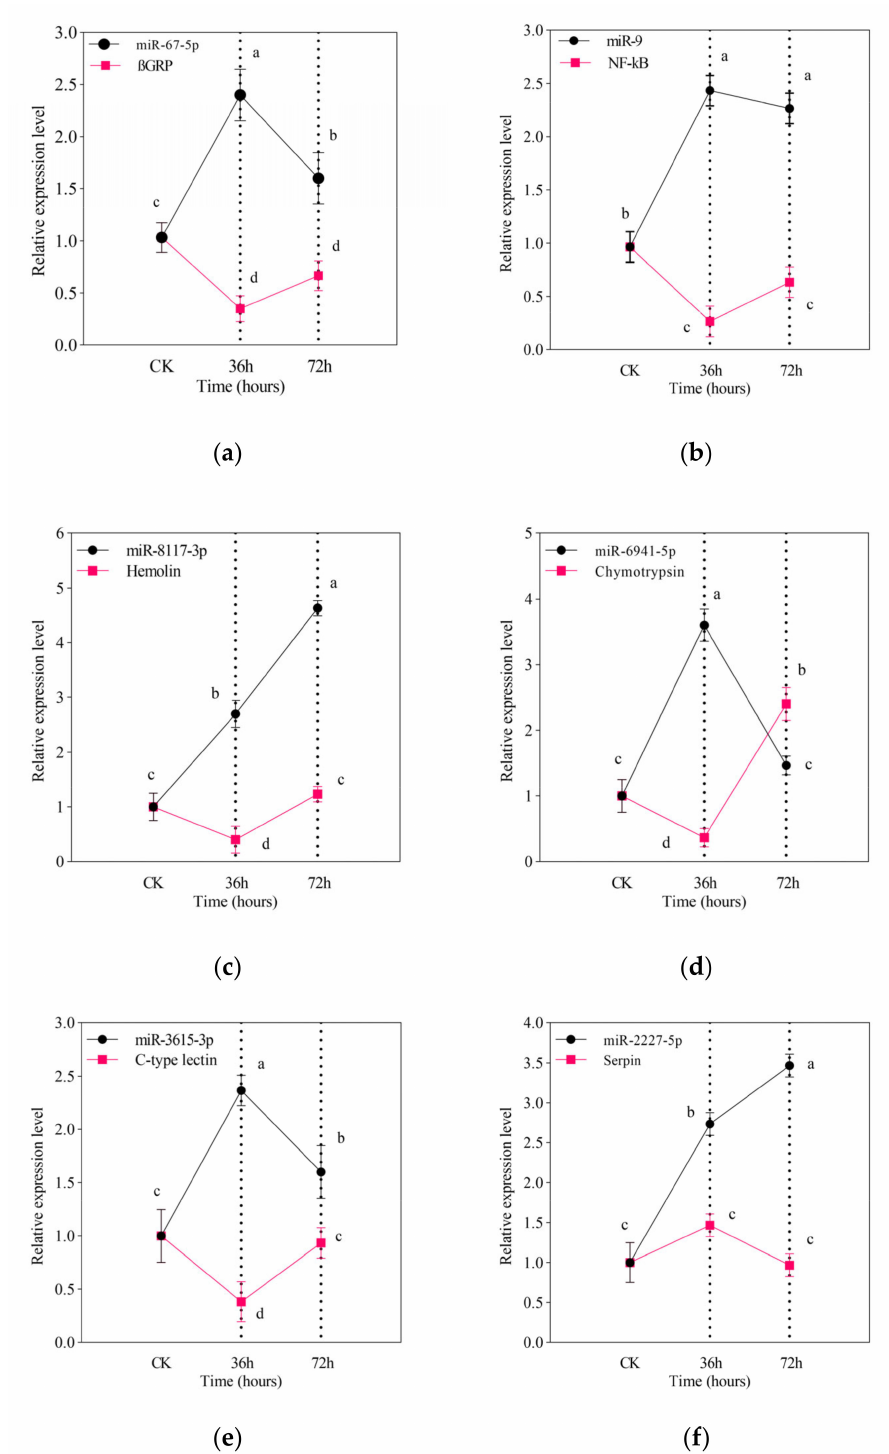
Figure 2. RT-qPCR validation of known miRNAs and their targets mRNAs. ( a ) miR-67-5p target β GRP; ( b ) miR-9 target NF- κ B; ( c ) miR-8117-3p target Hemolin; ( d ) miR-6941-5p target Chymotrypsin; ( e ) miR-3615-5p target C-type lectin; ( f ) miR-2227-3p target Serpin followed by M. anisopliae infection at different course (36 and 72 h). Relative fold change of mRNA and miRNAs were normalized using RPS13 and U6, respectively, as an internal control. Error bars show 95% confidence intervals (CI). Letters indicate significant differences at p <